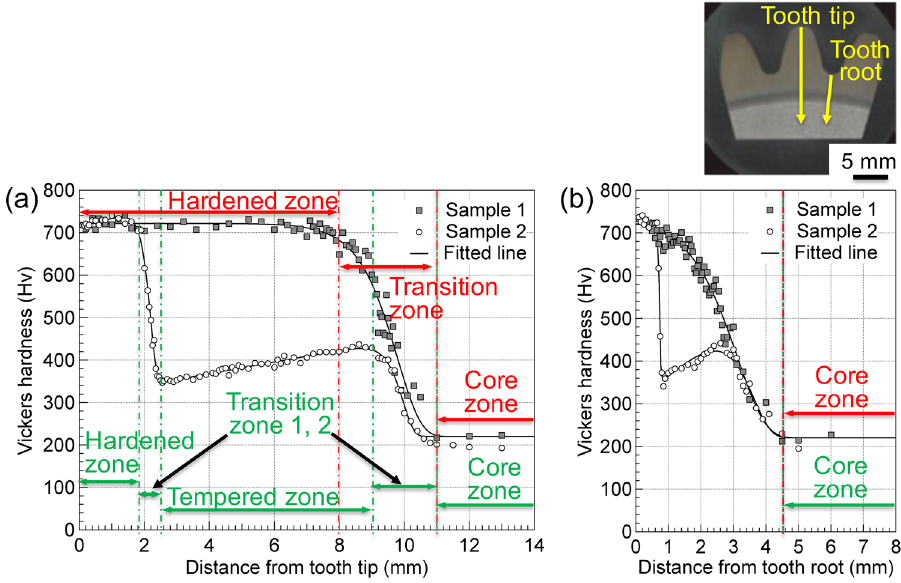
Figure 6. Hardness distribution profiles measured from the tooth tip ( a ) and the tooth root ( b ) for both gear samples.